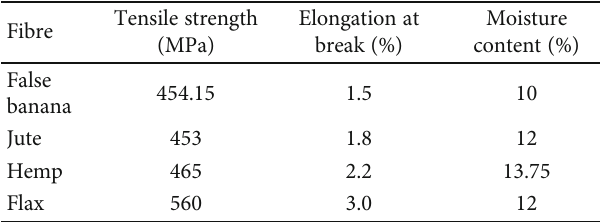
Table 1: Physical properties of false banana fi bres compared with other natural fi bres [4,